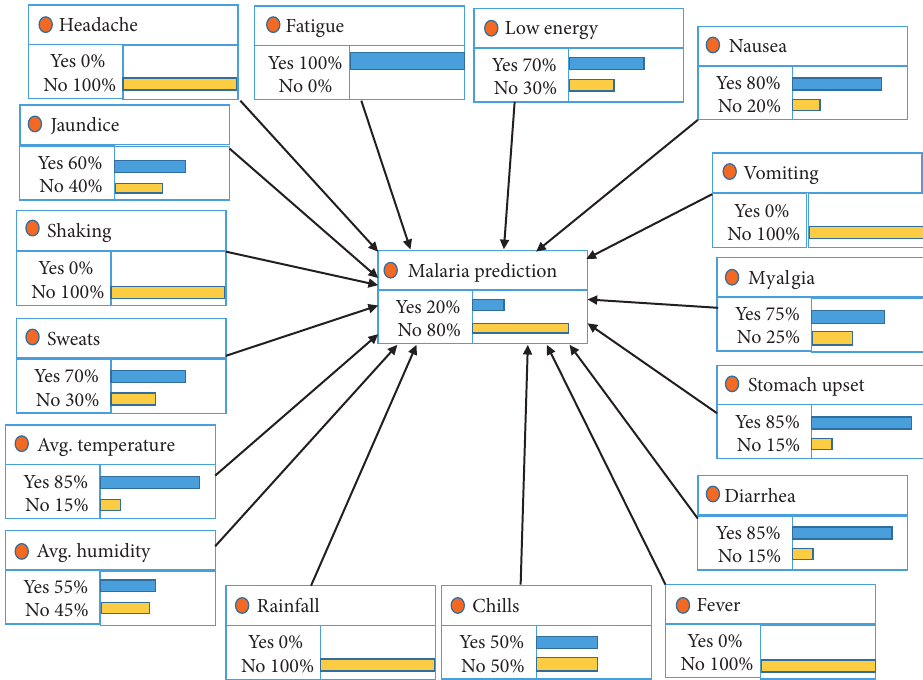
Figure 7: Proposed BN model predicted negative malaria